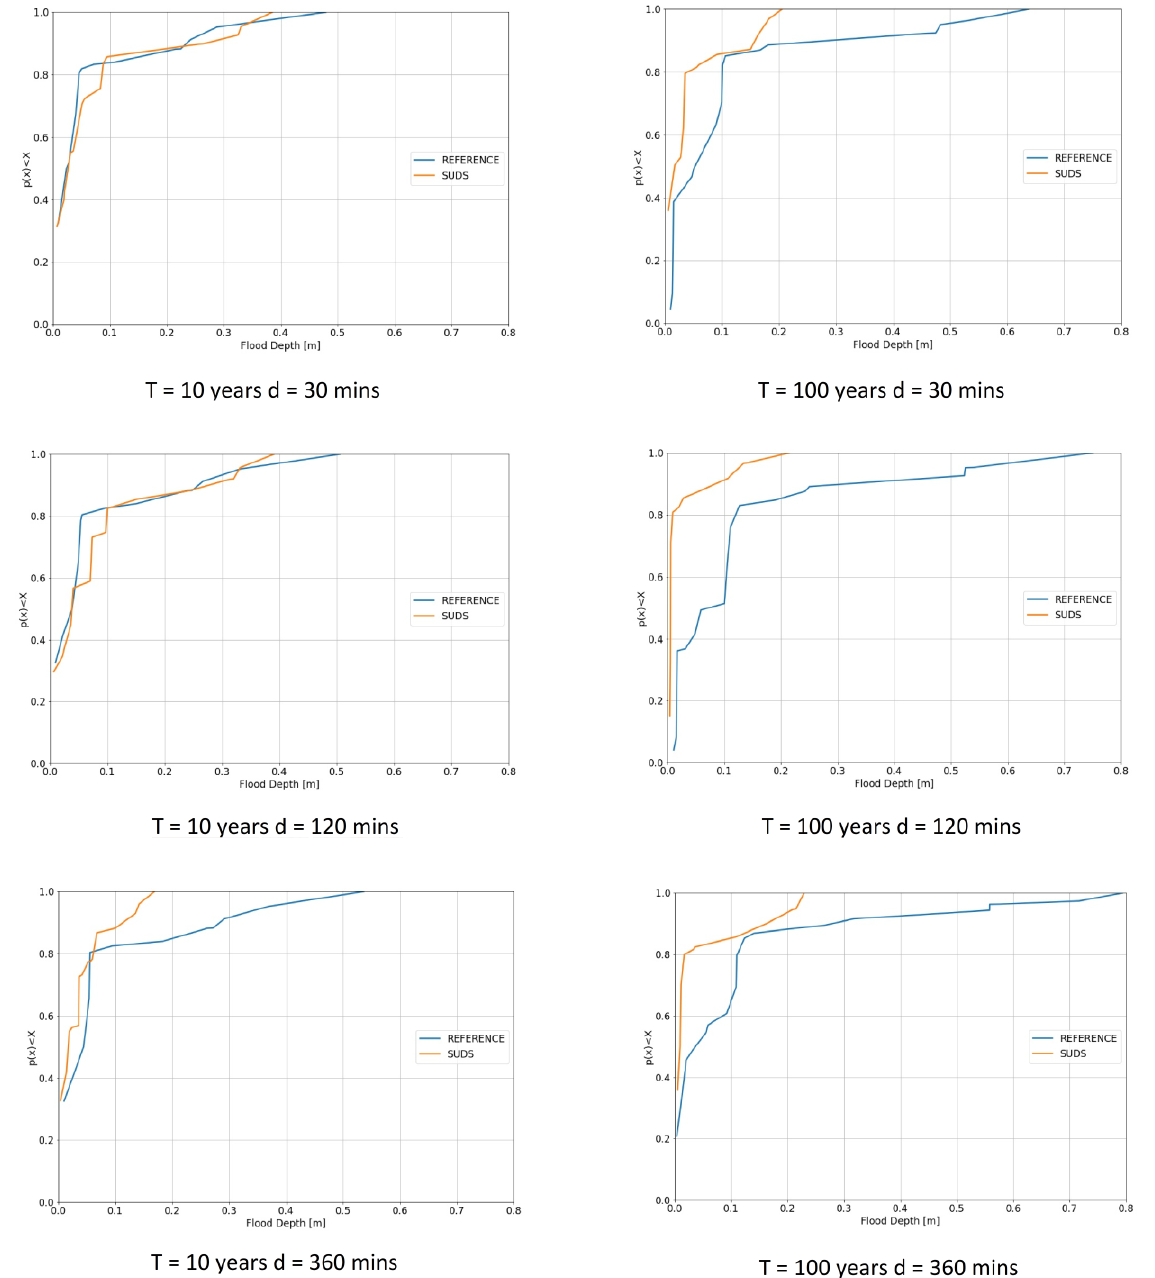
Figure 7. Cumulative density probability curve of flood depths for reference and SUDS scenarios in 6 rainfall events.